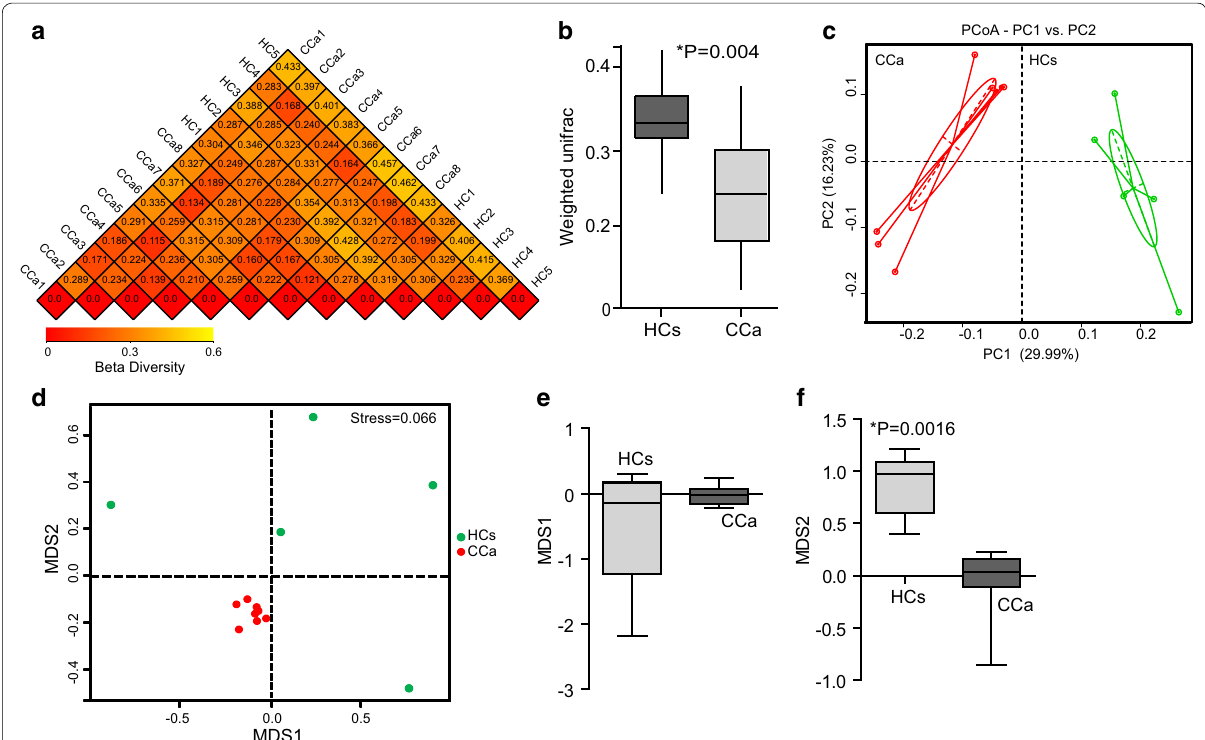
Fig. 2 Analysis of beta diversity in patient with cervical cancer compared with healthy controls. a Heatmap and b histogram of beta diversity based of Unifrac distance matrices (P 0.004 by t - test ). c PCoA analysis based of Unifrac distance matrices. Each sphere represents one sample. Samples = separate into two clusters. d NMDS plots. ( Green healthy control samples, HC1-HC5; Red patient samples, CCa1–CCa8). e, f Differences across groups are established at the first and second MDS ( e , MDS1 and f , MDS2) values. MDS1, P > 0.05; MDS2, P 0.0016 by Mann–Whitney U test =